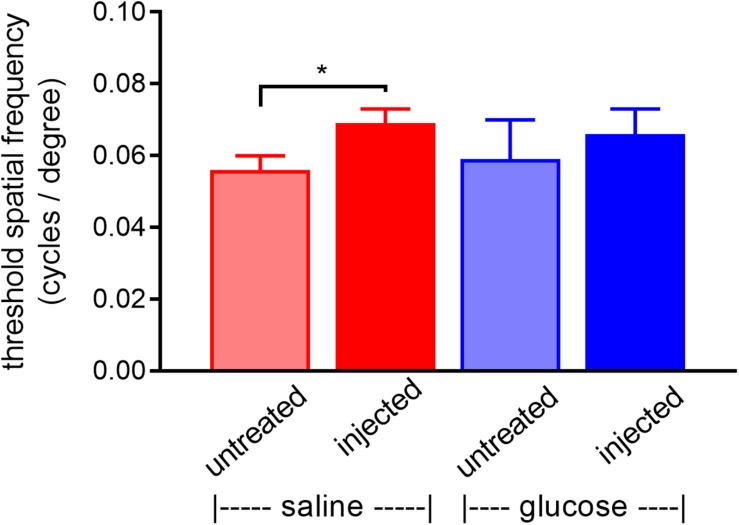
Performance of Rd1 mice in the optomotor tracking test undertaken at P24, following 10 days of treatment. Rd1 mice received a daily unilateral subconjunctival injection of glucose or saline; the respective contralateral eyes were untreated. Values represent mean ± SEM, where n = 11–13. ∗P < 0.05 by Student’s paired t-test (saline-injected vs. untreated contralateral eyes). There were no significant differences between glucose-injected and untreated contralateral eyes (Student’s paired t-test) or between saline-injected eyes and glucose-injected eyes (Student’s unpaired t-test).